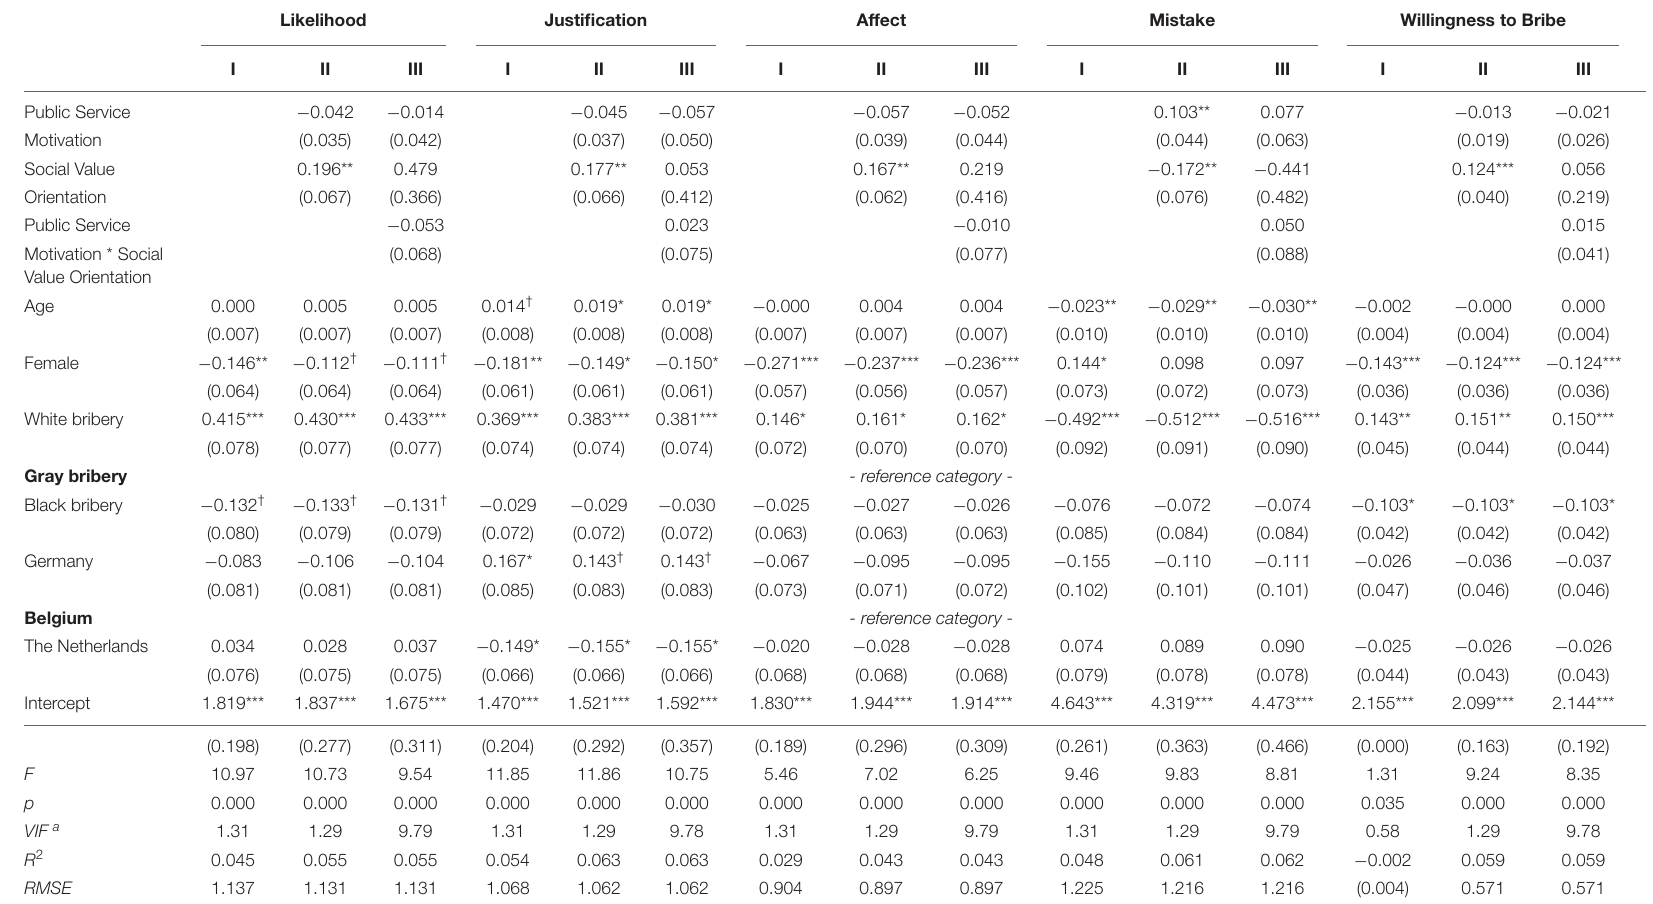
TABLE 2 | Regression estimates on Willingness to Bribe (pooled